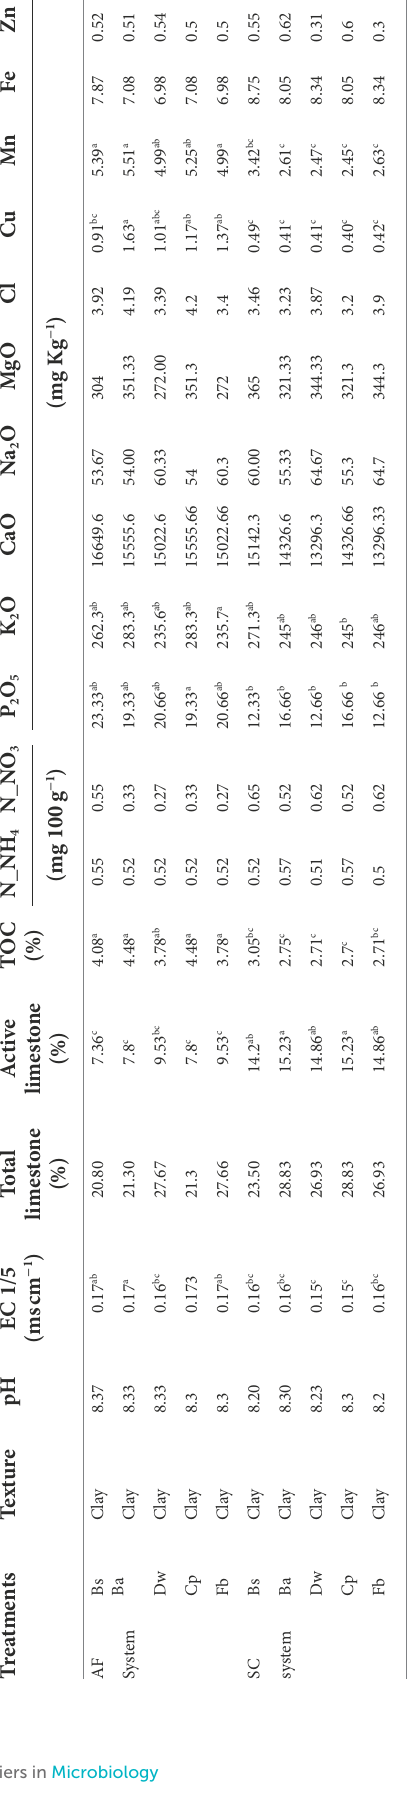
performed based on the output-normalized data. QIIME software (version 1.9.1) was used to compute the alpha diversity indices